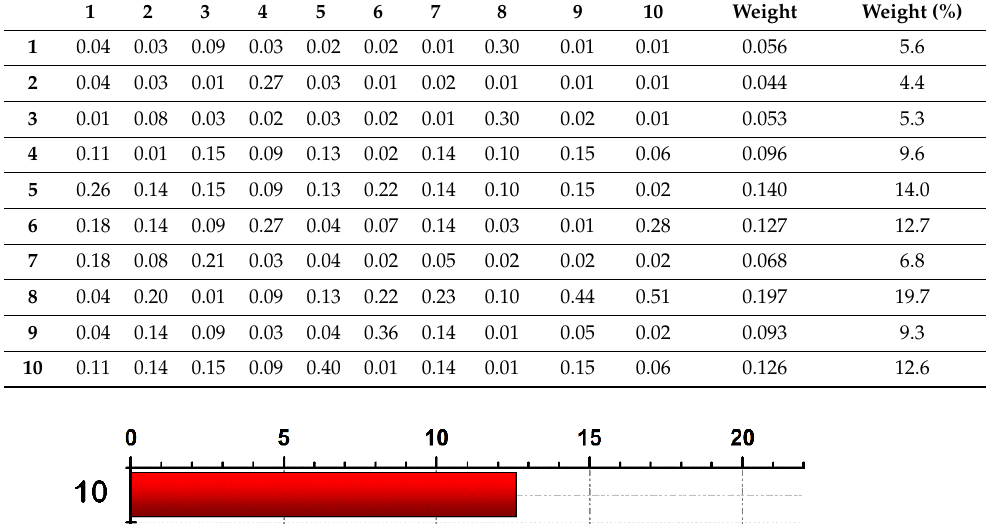
Table 5. Standardized matrix for the main criteria.